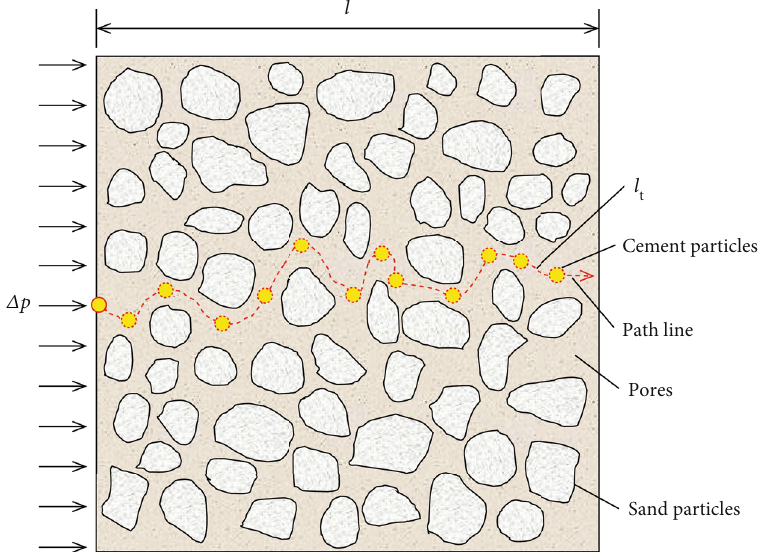
Figure 3: Schematic of slurry di ff usion tortuous e ff